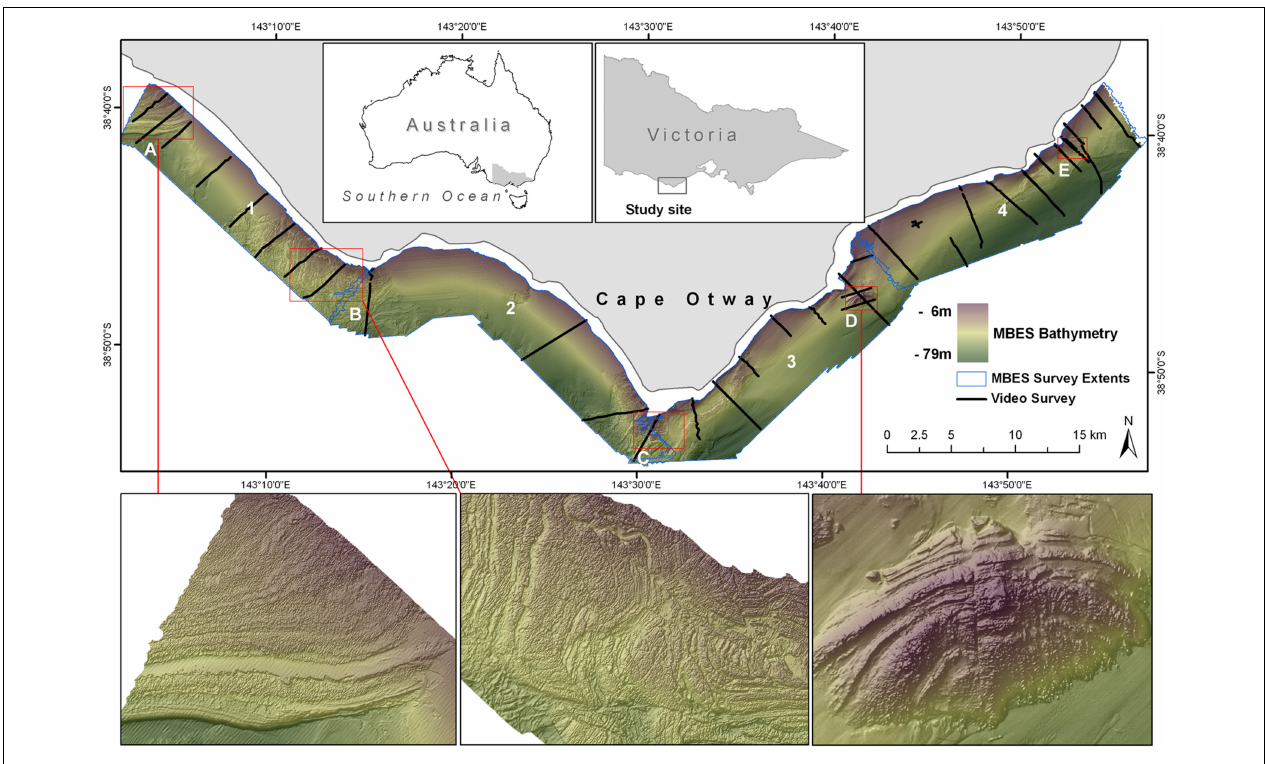
FIGURE 1 | Location and depth structure of the 624km 2 study site at Cape Otway south-eastern Australia superimposed with hill-shaded MBES bathymetry. Numerals (1–4) represent each of the four MBES survey blocks (outlined in blue) undertaken at the site. Letters (A–E) identify major